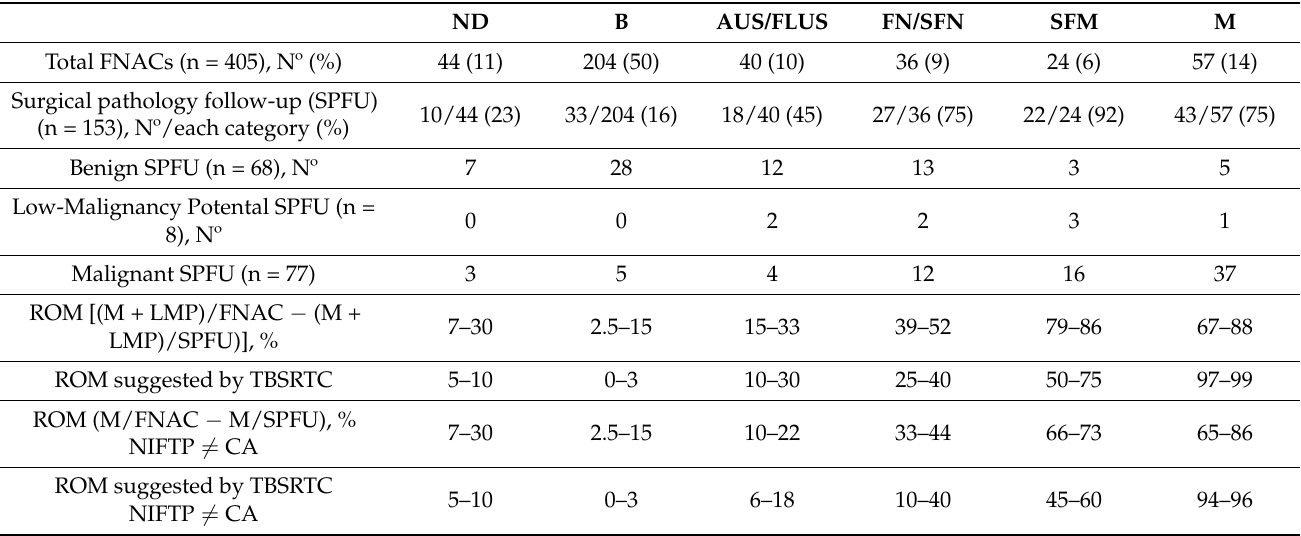
Table 3. Distribution of TBSRTC categories based on SPFU, biological behavior and